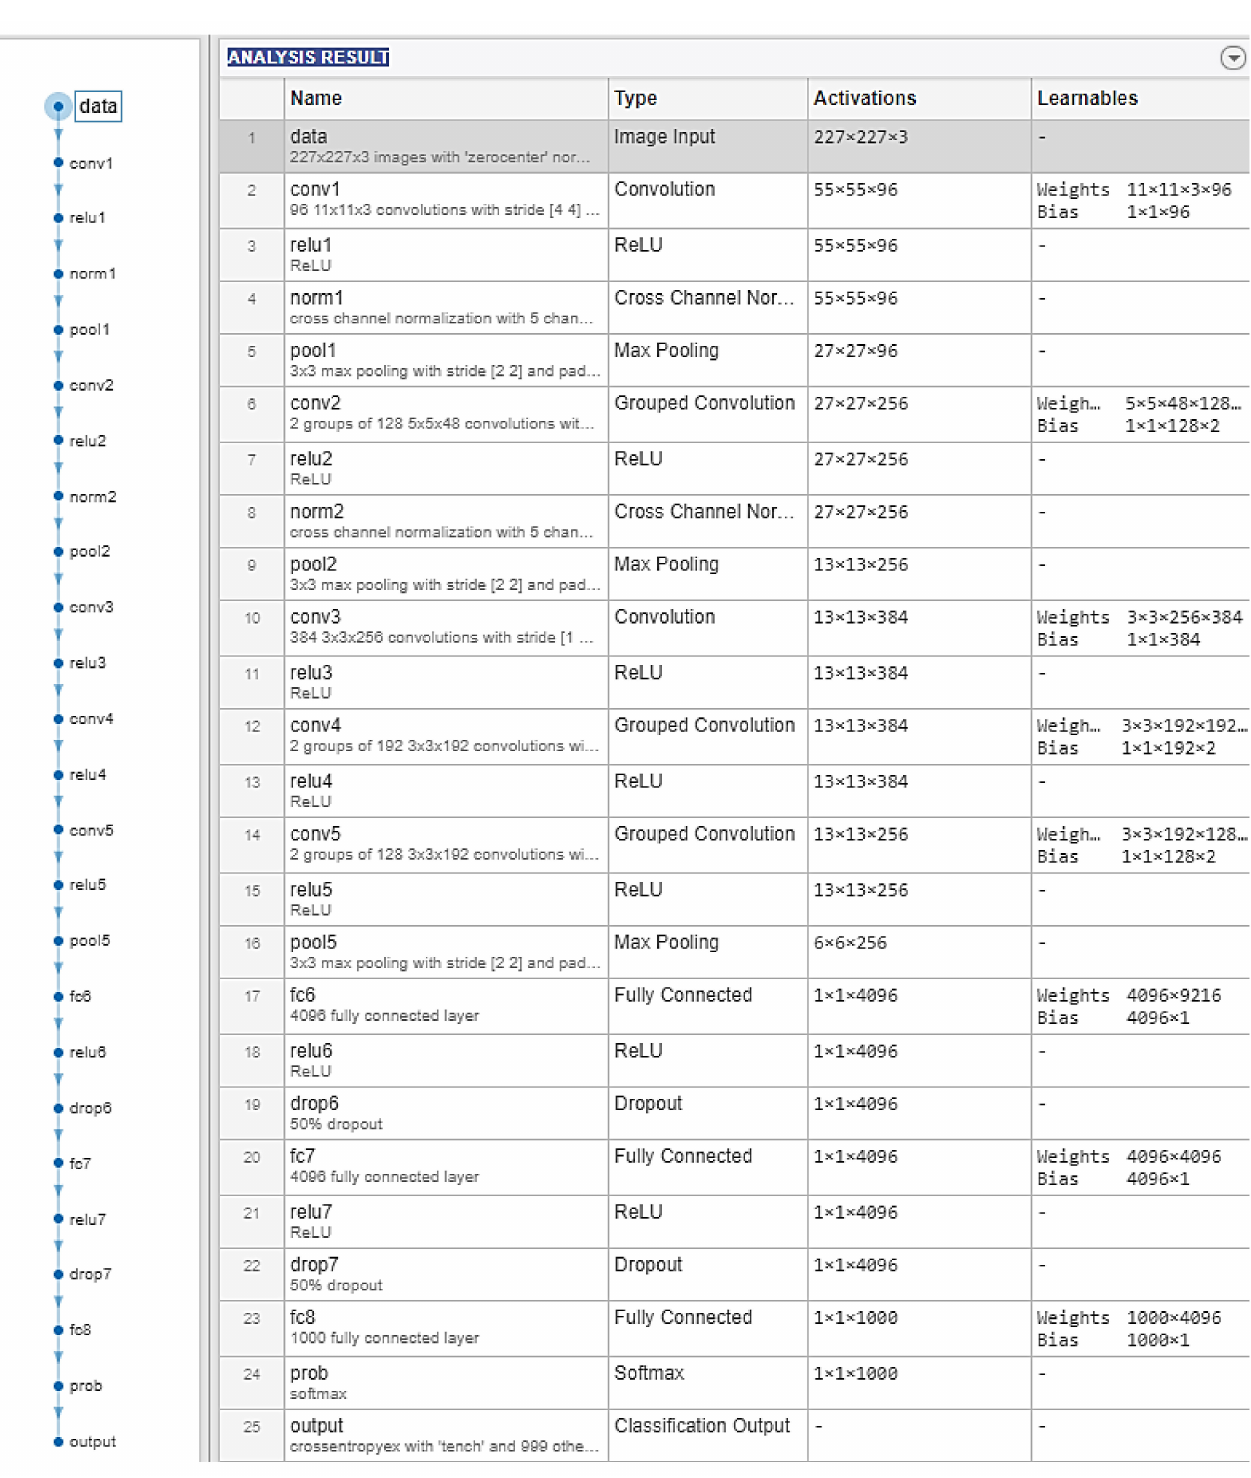
Figure 12. Architecture of used